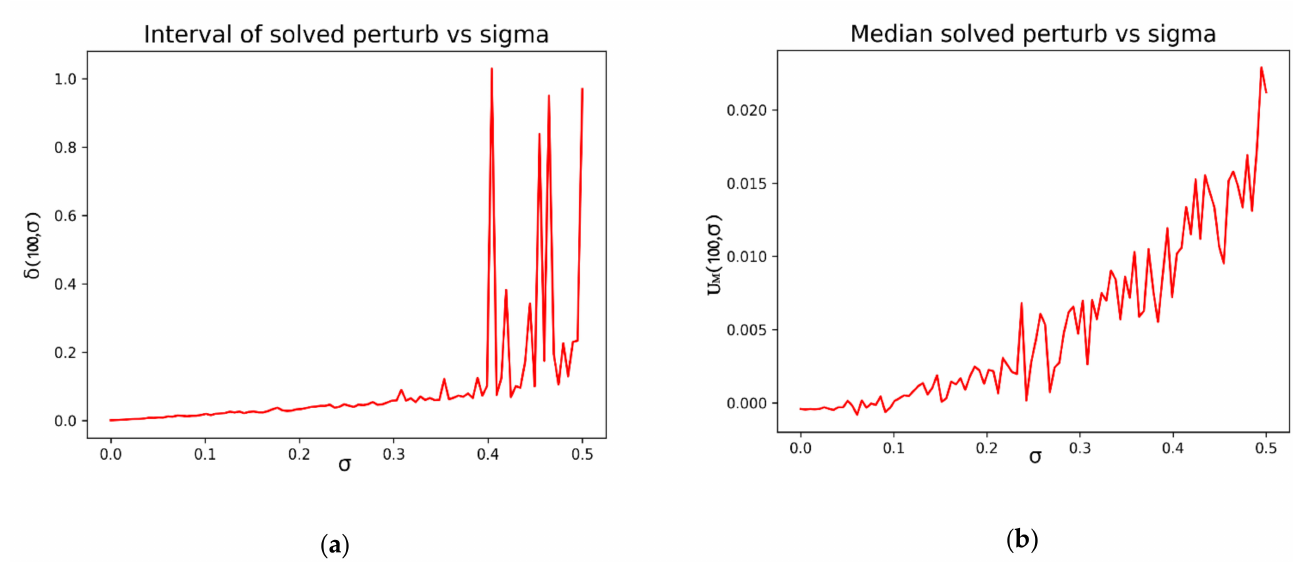
Figure 2. Effect on the solution of different standard deviations for 200 samples of the normal perturbation term: ( a ) Range of the differences δ ( 100, σ ) ; ( b ) Median of the difference between the numerical solutions and the exact solutions at right extreme of the interval U M ( 100, σ )